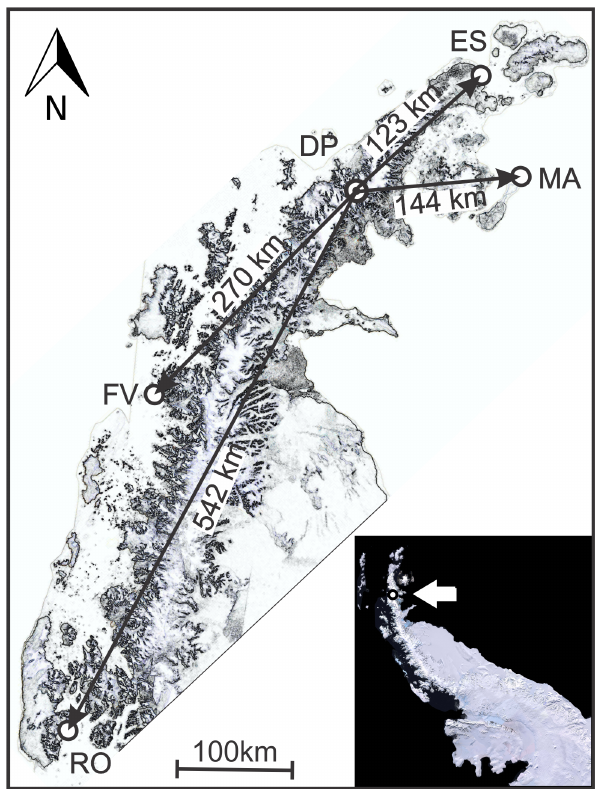
Figure 1. The four Antarctic Stations, Esperanza (ES), Marambio (MA), Faraday–Vernadsky (FV) and Rothera (RO), and the bore- hole at the DP, on the northern Antarctica Peninsula. The white ar- row in the lower right corner inset shows the location of the DP on the peninsula. Both maps were modified from a pan-sharpened scene of the Landsat Image Mosaic of Antarctica (LIMA) by USGS (https://lima.usgs.gov/, last access: February